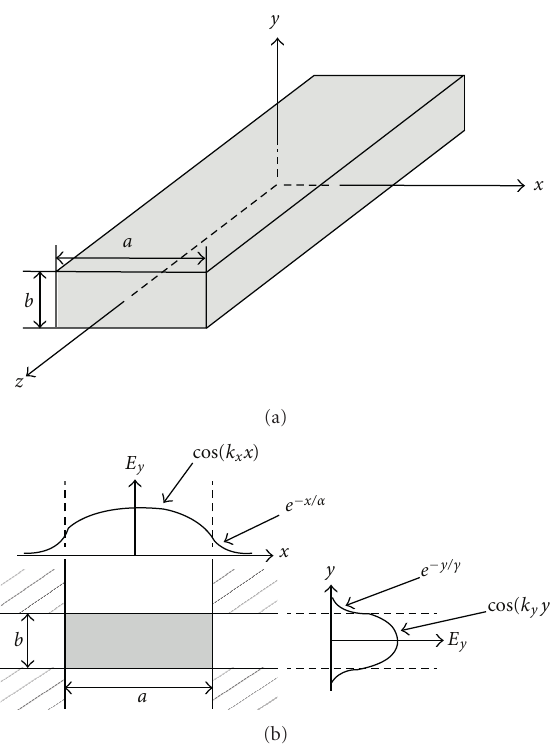
Figure 2: Dielectric waveguide. Adapted from [1] © 1969.